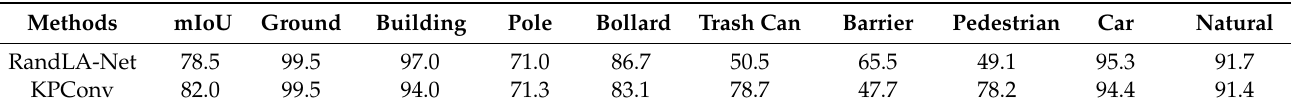
Table 2. Intersection over union (IoU) metric of RandLA-Net and KPConv for the different classes of the Semantic3D dataset. mIoU refers to the mean of IoU of each class (%).